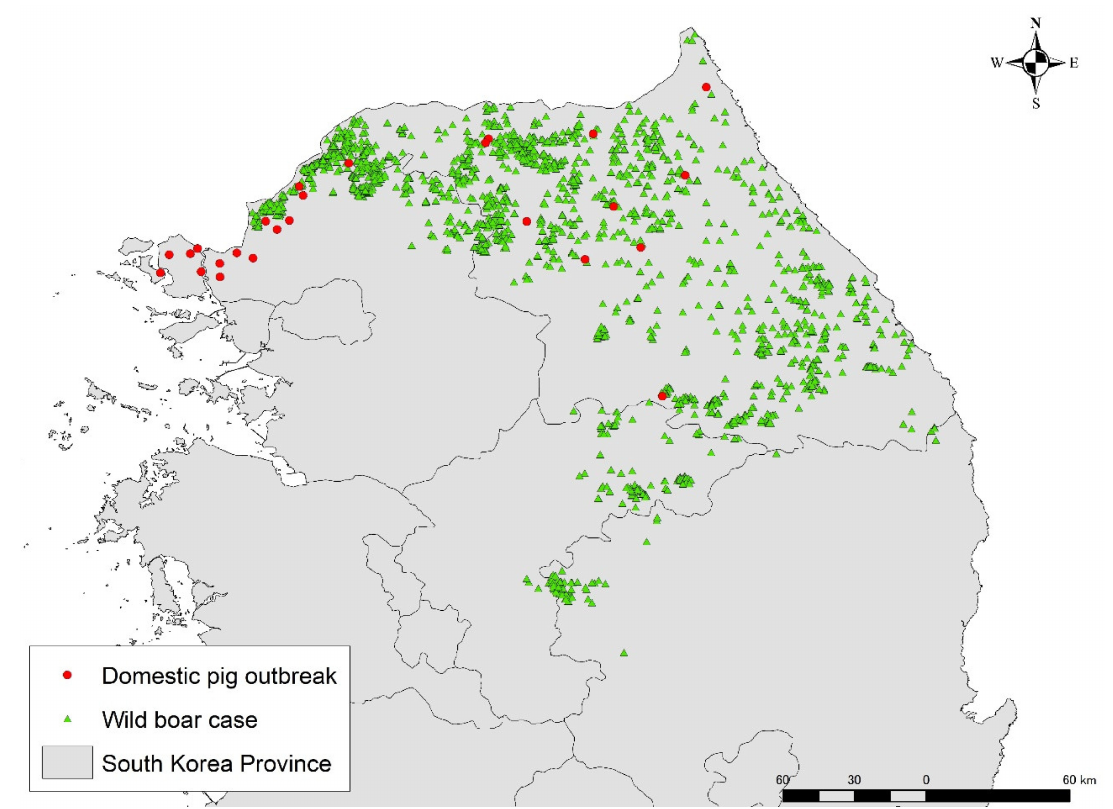
Figure 1. African swine fever notifications in South Korea as of the end of September 2022. The map was depicted in ArcGIS software version 10.8.1 based on the given data. Red circle indicates outbreaks in domestic pig farms, while green triangles represent wild boar